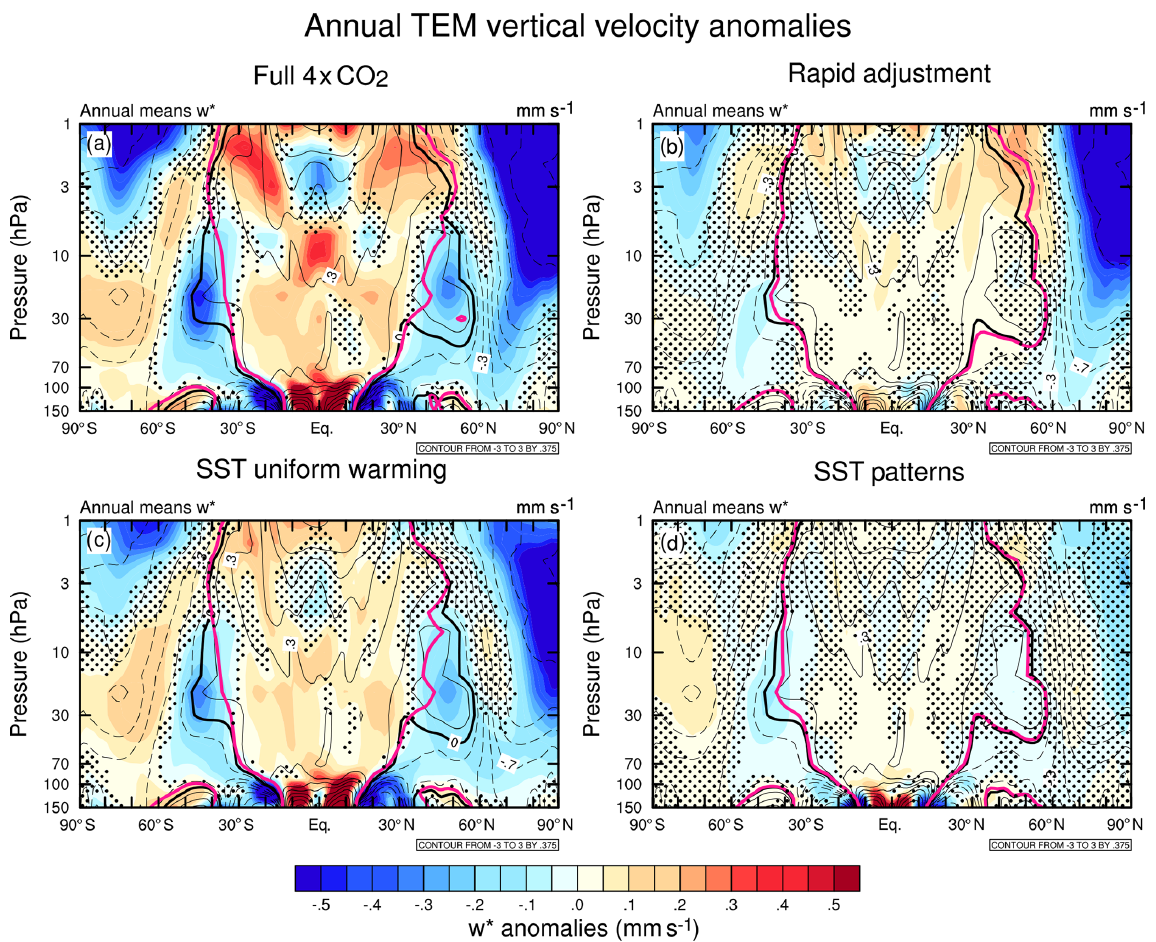
Figure 4. As in Fig. 2, but for the annual-mean TEM residual vertical velocity anomalies (mms − 1 ) between 150 and 1hPa. Contours show the piControl climatology and range from − 3 to 3mms − 1 in increments of 0.375mms − 1 . The thick black lines denote the turnaround latitudes ( w ∗ = 0) in piControl, and pink thick lines denote each perturbation experiment,